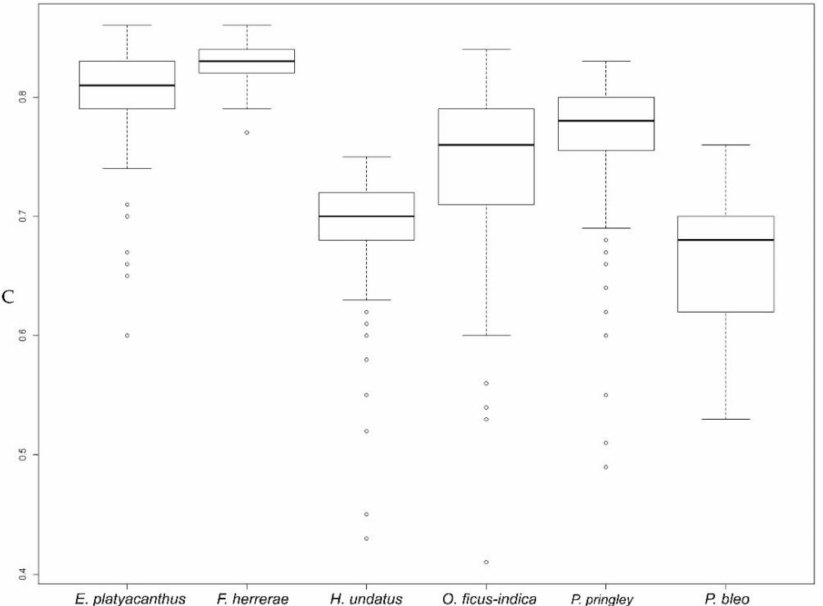
Figure A3. Values of circularity index for seeds of the species Echinocactus platyacanthus , Ferocactus herrerae , Hylocereus undatus , Opuntia ficus-indica , Pachycereus pringley , and Pereskia bleo .